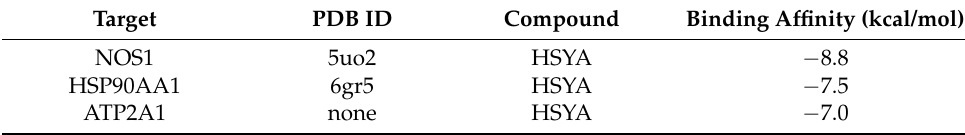
Table 1. Component and target binding